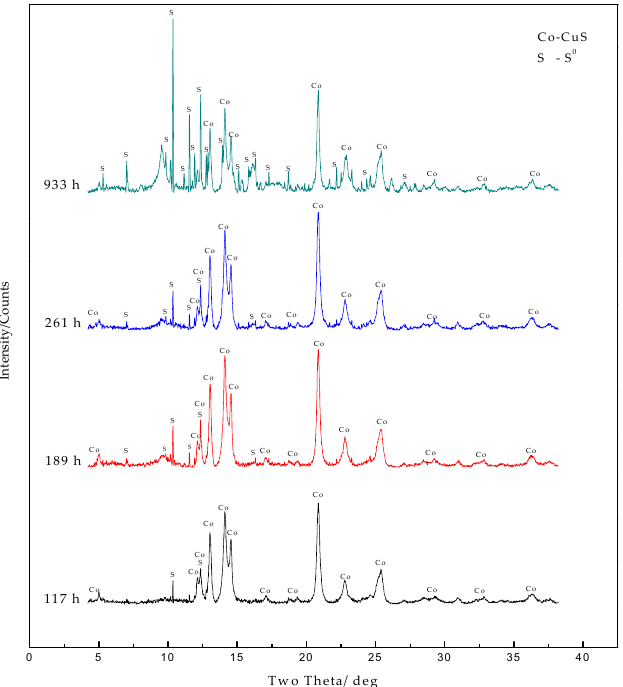
Figure 4. SRXRD results of the phase transformation process in the second stage of chalcocite acidic ferric sulfate leaching